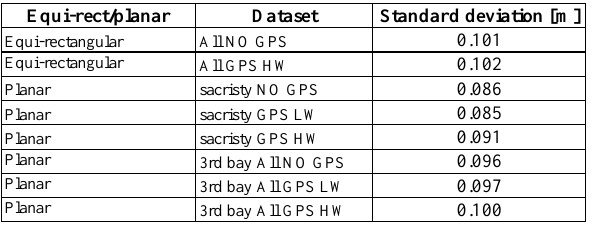
Table 11. DSM comparison.